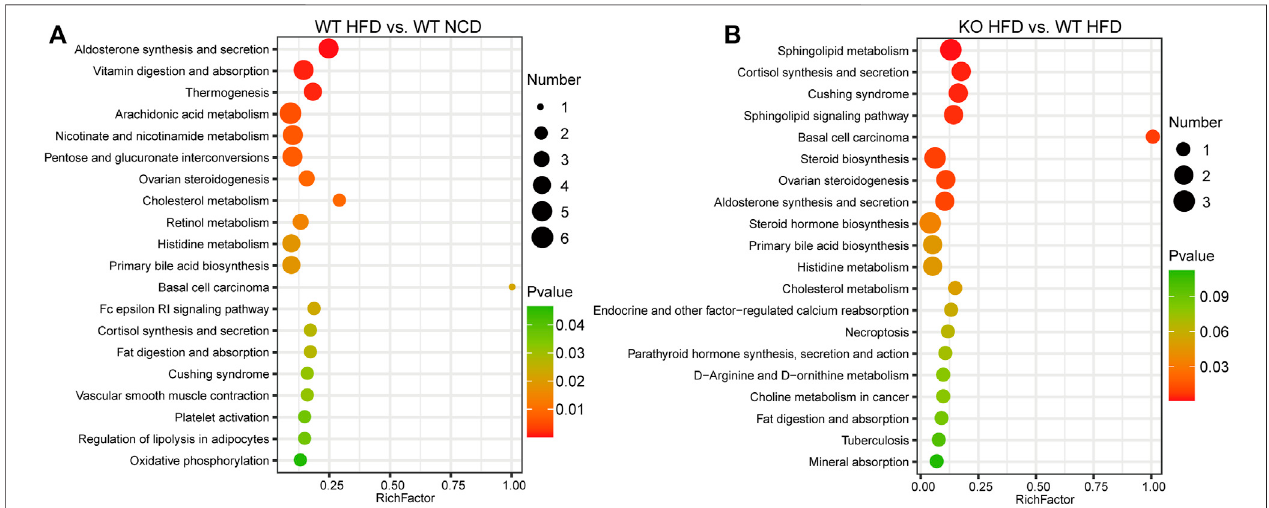
FIGURE5| Signalpathwaysenrichmentanalysis. (A) KEGGanalysisindicatedthetop20enrichedpathwaysbetweenWT-HFDandWT-NCDmice. (B) Thetop20 enriched pathways between CD1d KO-HFD and WT-HFD mice. HFD, high-fat diet; KEGG, Kyoto Encyclopedia of Genes and Genomes; KO, knockout; NCD, normal control diet; WT,